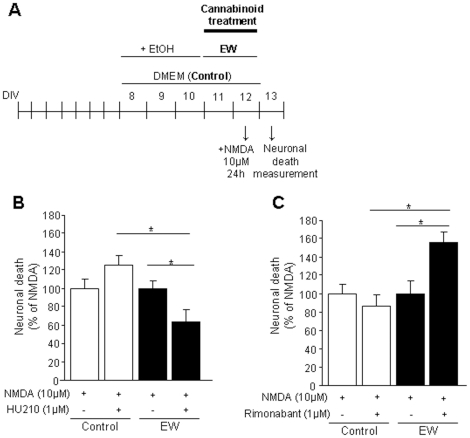
The acute manipulation of the endocannabinoid system influences neuronal viability during ethanol withdrawal.Effects of the acute activation or blockade of the endocannabinoid signaling on neuronal viability in control (neurons not exposed to ethanol) or ethanol–withdrawn neurons (EW). (A) Representative scheme of the experimental protocol. (B) The administration of the non-specific cannabinoid agonist HU-210 (1 µM) during ethanol withdrawal decreases NMDA-induced neuronal death in ethanol-withdrawn neurons. Interestingly, the neuroprotective effect of HU-210 is specific of alcohol withdrawal situation, since it has no effect on control neurons. (C) The acute administration of the CB1 antagonist rimonabant (1 µM) increases NMDA-induced neuronal death in alcohol-withdrawn neurons. Again, this effect is specific of the withdrawal situation and rimonabant, when administered acutely, has no effect on control condition. Values are normalized to NMDA and are means ± SEM (n = 14–18 wells/condition; N = 4 plates). Data were analyzed by the ANOVA test followed by the Fisher's PLSD test (* P<0.05).